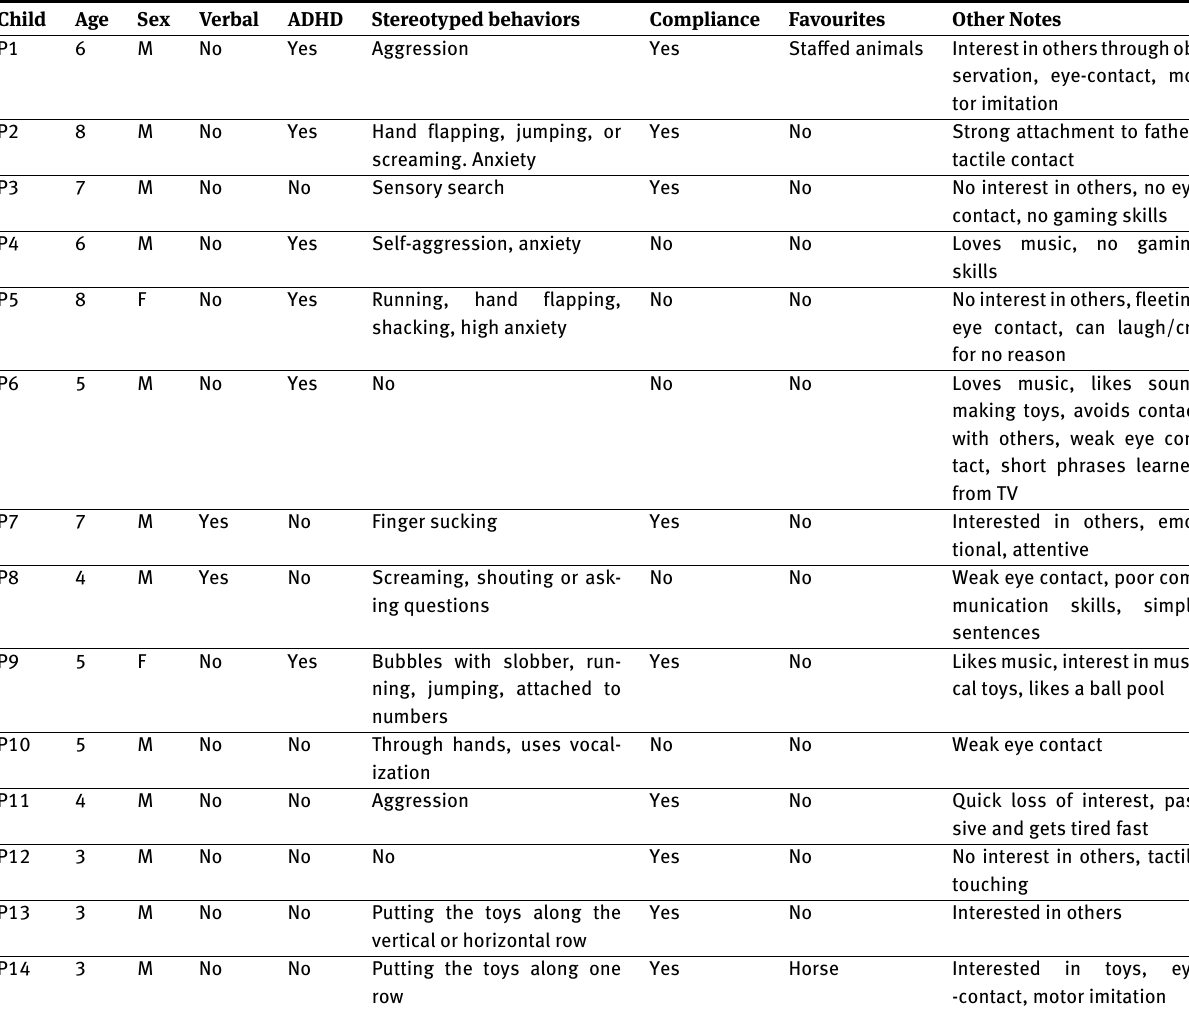
Table 1: Children’s